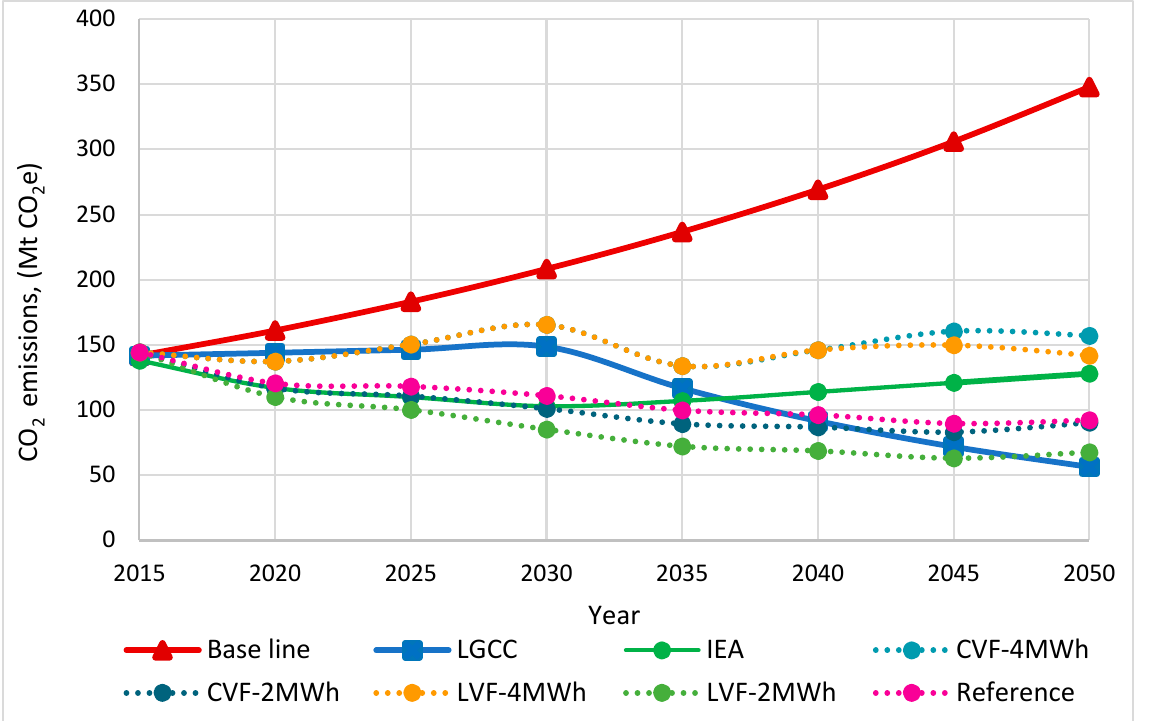
Figure 11. GHG mitigation in the NSS to 2050. Fuente: own elaboration with data from this work and previous publication [2,30,31].